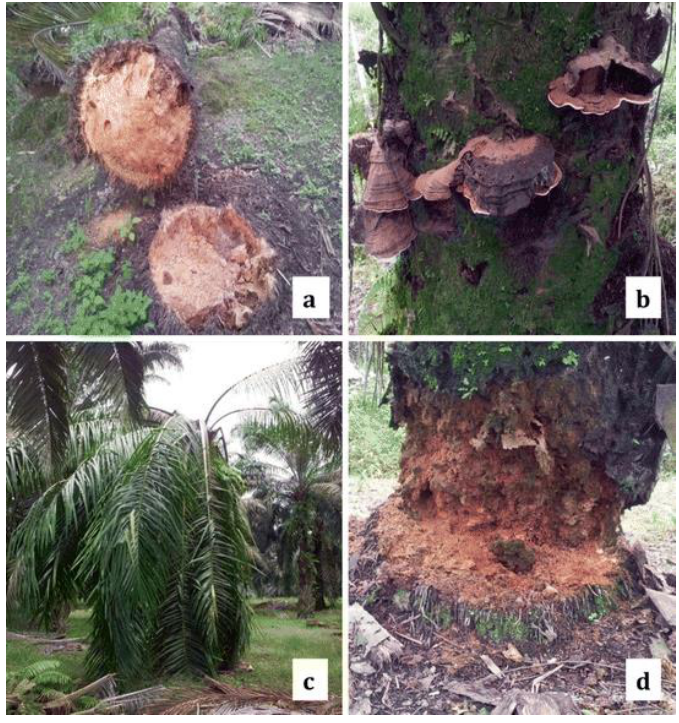
Figure 1. ( a – d ) Oil palm infected with G. boninense with ( a ) rotten bole tissue, ( b ) basidiomata of G. boninense, ( c ) foliar symptoms, ( d ) decaying oil palm bole tissues [20]. G. boninense , ( c ) foliar symptoms, ( d ) decaying oil palm bole tissues